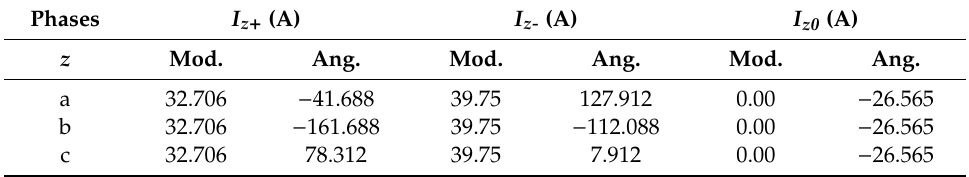
Table 4. Positive-, negative-, and zero-sequence line currents in the bus after ZSCC